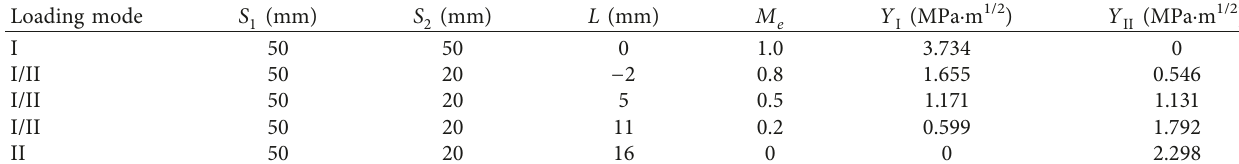
Table 3: The values of Y I and Y II for different specimens.